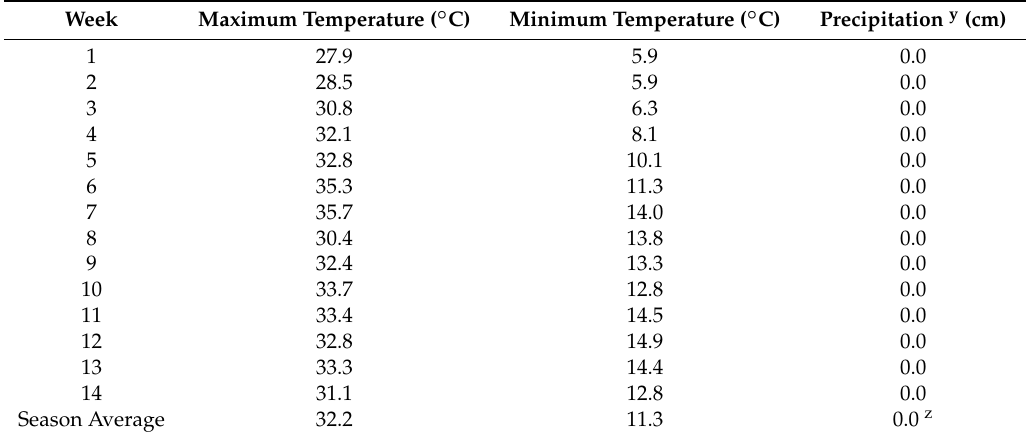
Table 2. Growing season (15 May–21 August 2012) weekly total precipitation and average maximum and minimum temperatures x ,